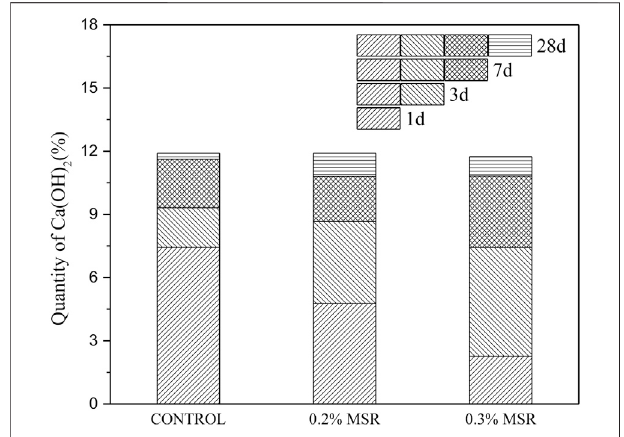
Frontiers in Materials |